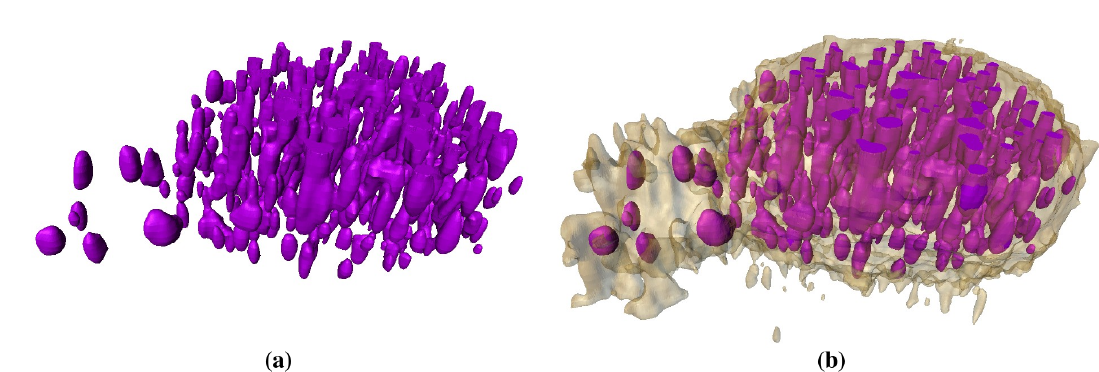
Figure 9. 3D volume reconstruction of a lipid droplet. ( a ) internal structure of lipid droplet; ( b ) whole